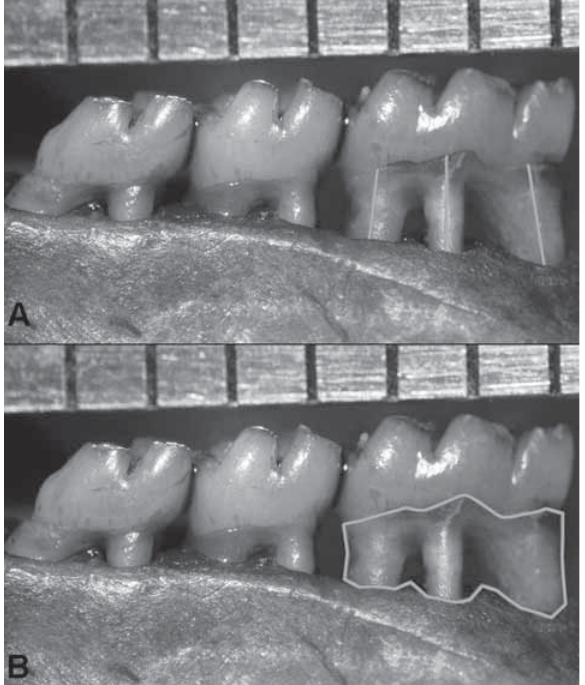
Figure 3- Photograph of alveolar bone loss evaluated morphometrically by measuring the linear distance between the cementoenamel junction and alveolar